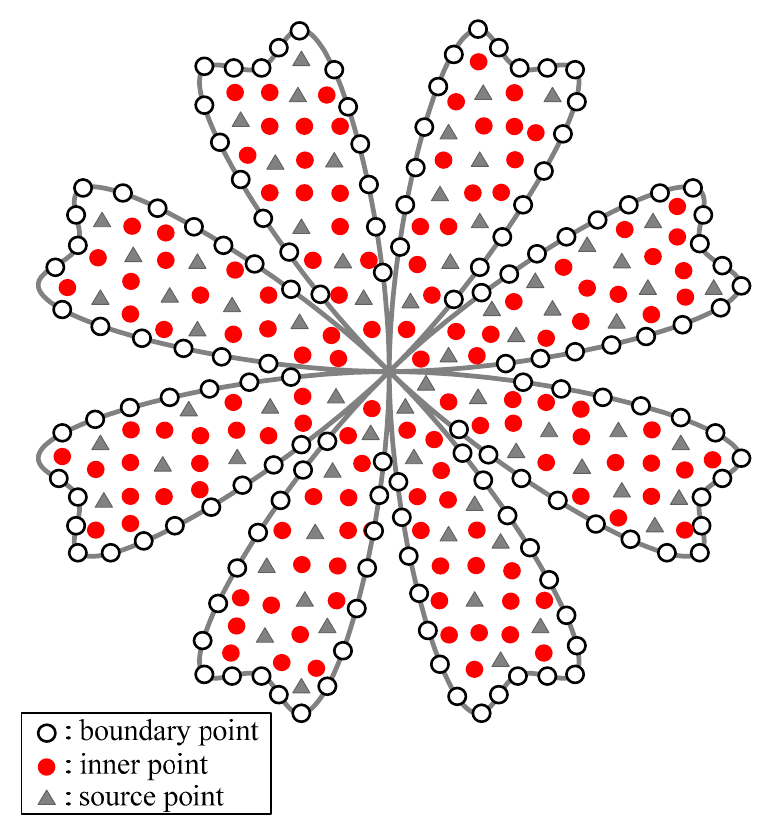
Figure 7. Layout of the boundary, source and inner points.